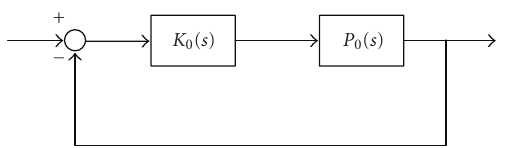
Figure 1: Typical control loop with nominal controller and plant.